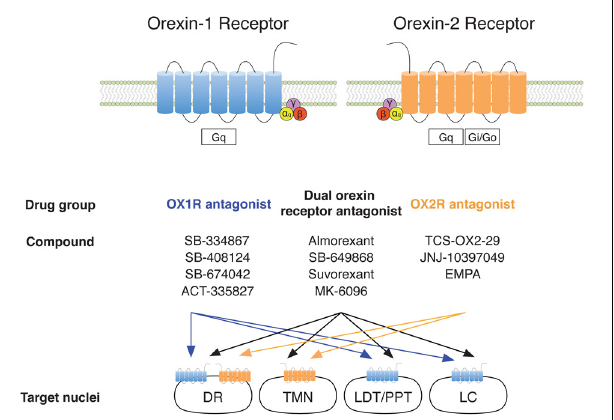
FIGURE 1 | Orexin receptors and antagonists. Abbreviations: OX 1 R, type 1 orexin receptor; OX 2 R, type 2 orexin receptor; DR, dorsal raphe; TMN, tuberomammillary nucleus; LDT, laterodorsal tegmental nucleus; PPT, pedunculopontine tegmental nucleus; LC, locus coeruleus